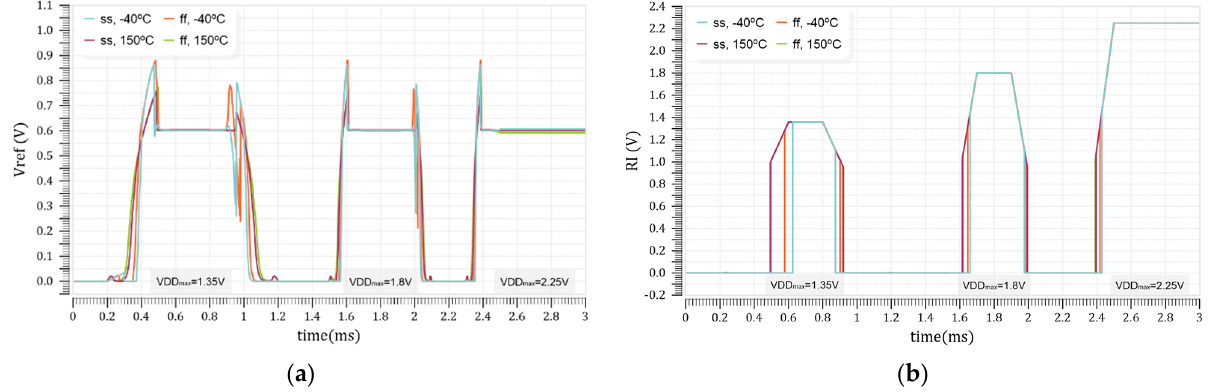
Figure 5. Simulation results for BGR#1 (22 nm, 1.8 V) in PVT corners. ( a ) Vref , ( b ) RI.